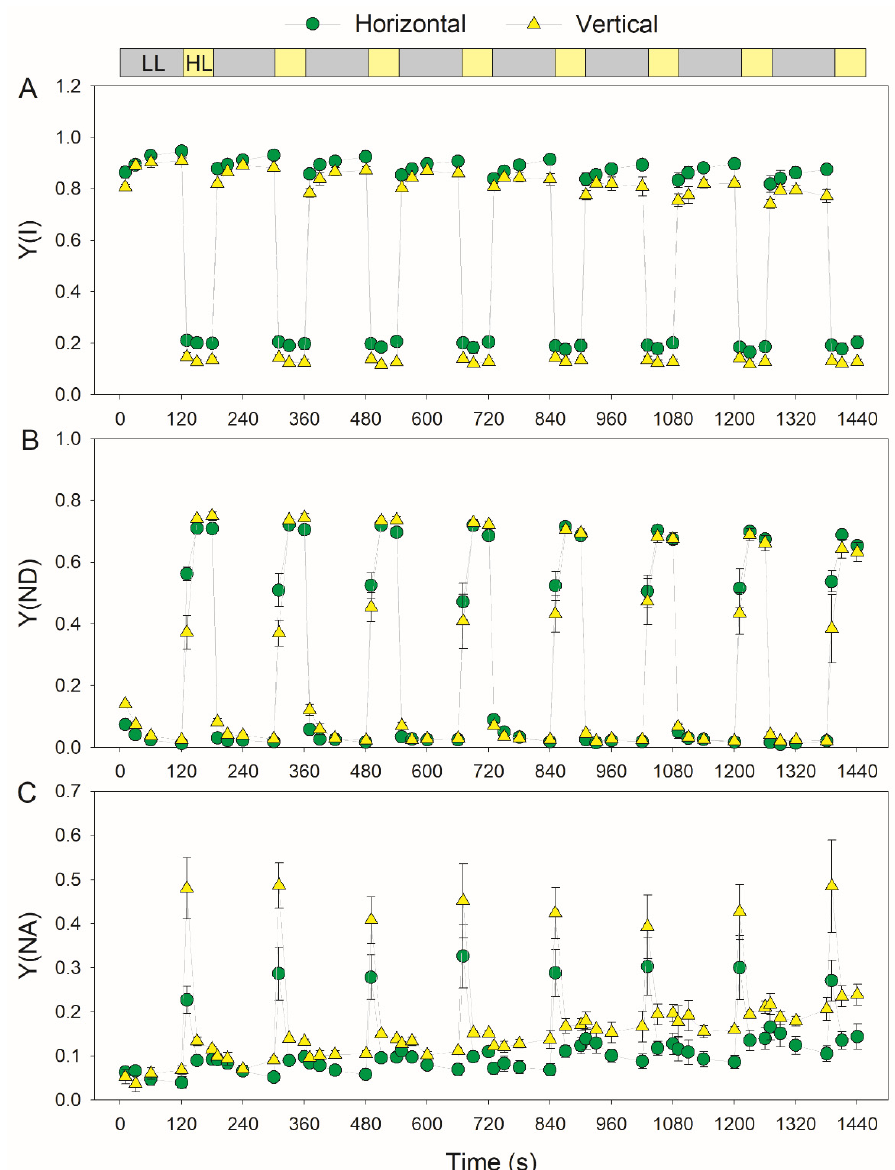
Figure 3. Changes in the PSI parameters under fluctuating light in the horizontal (leaf angle = 0°) and vertical (leaf angle = 60–65°) leaves. After illumination at 1809- μ mol photons m − 2 s − 1 for 20 min for photosynthetic induction, the leaves were exposed to fluctuating light alternating between 59- and 1809- μ mol photons m − 2 s − 1 every 2 min for 24 min. ( A ) Y(I), the quantum yield of PSI photo- chemistry; ( B ) Y(ND), the quantum yield of PSI nonphotochemical energy dissipation due to donor- side limitation; and ( C ) Y(NA), the quantum yield of PSI nonphotochemical energy dissipation due to acceptor-side limitation. Data are shown as the means ± SE ( n = 3).